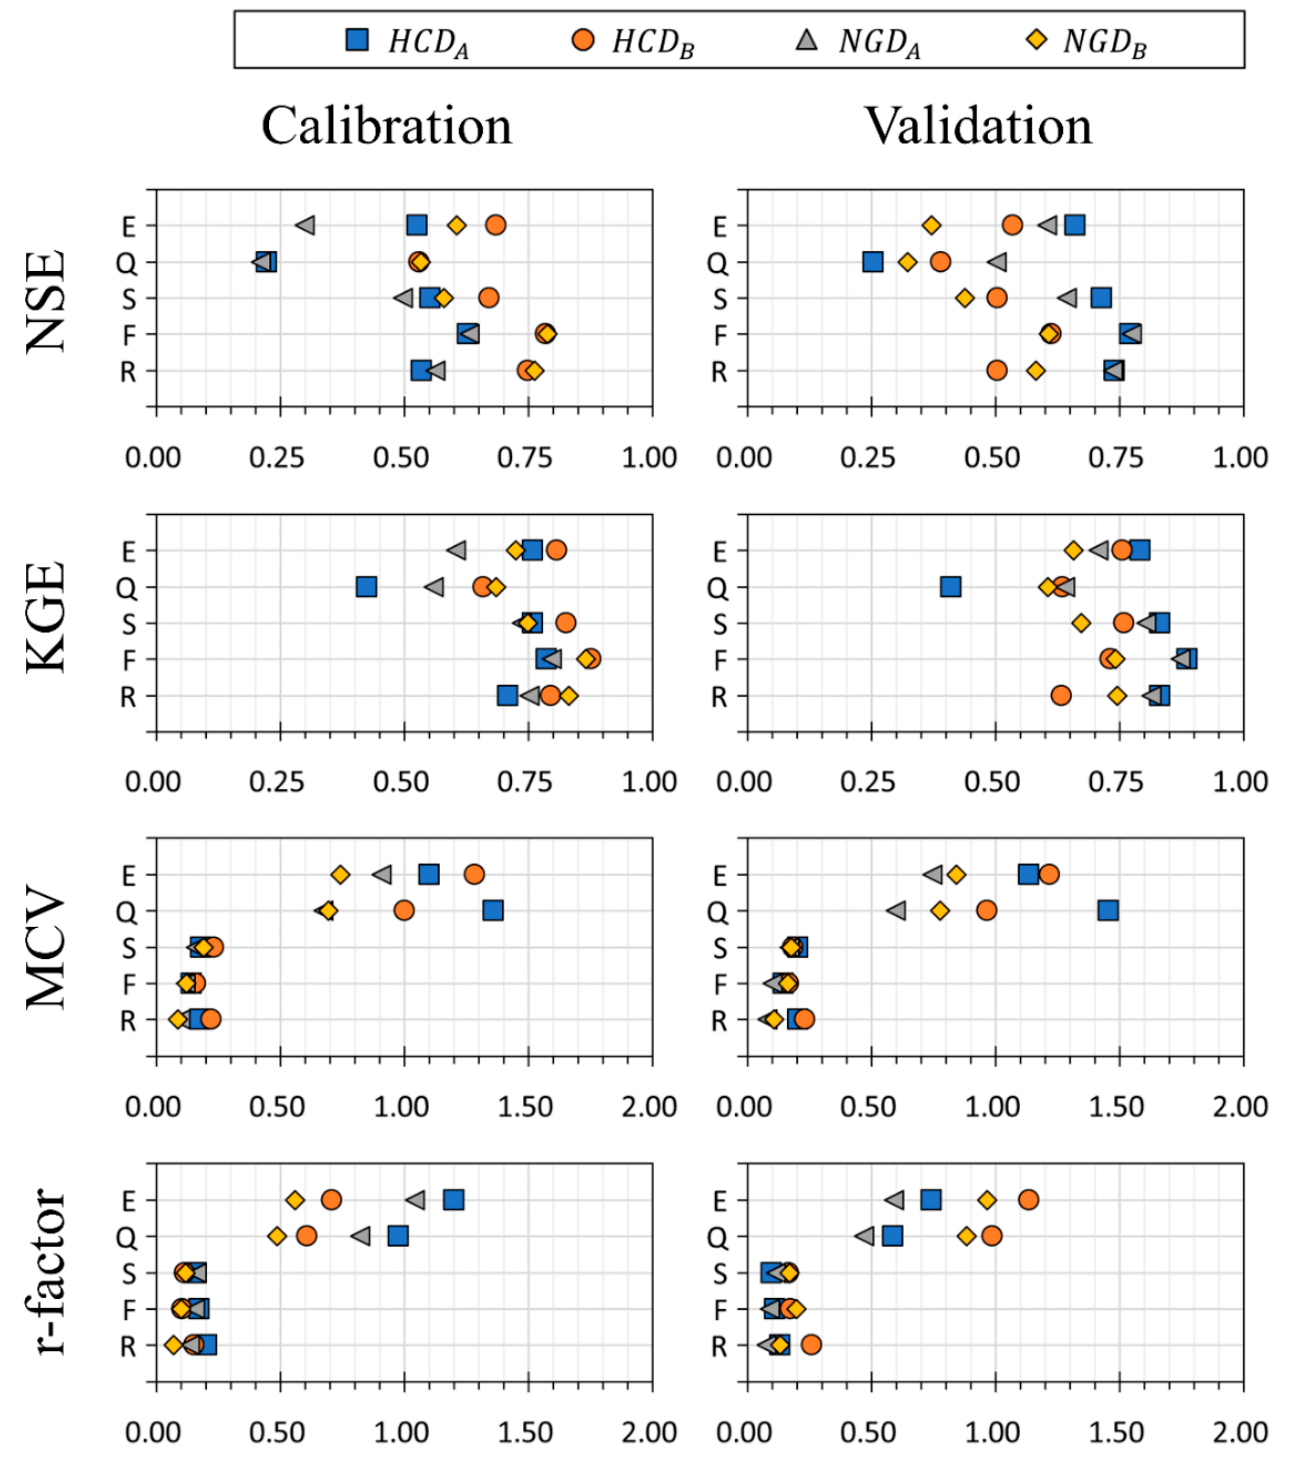
Figure 4. Performance metrics (NSE and KGE) and uncertainty metrics (MCV and r-factor) between observed and simulated daily stream flow for calibration period and validation period.